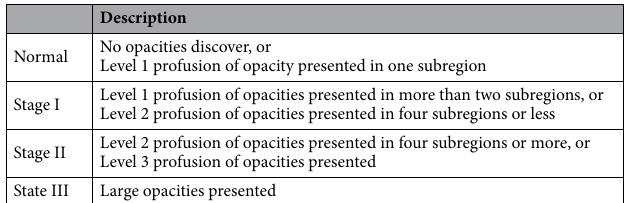
Table 3. Rule-based determination of final stage according to